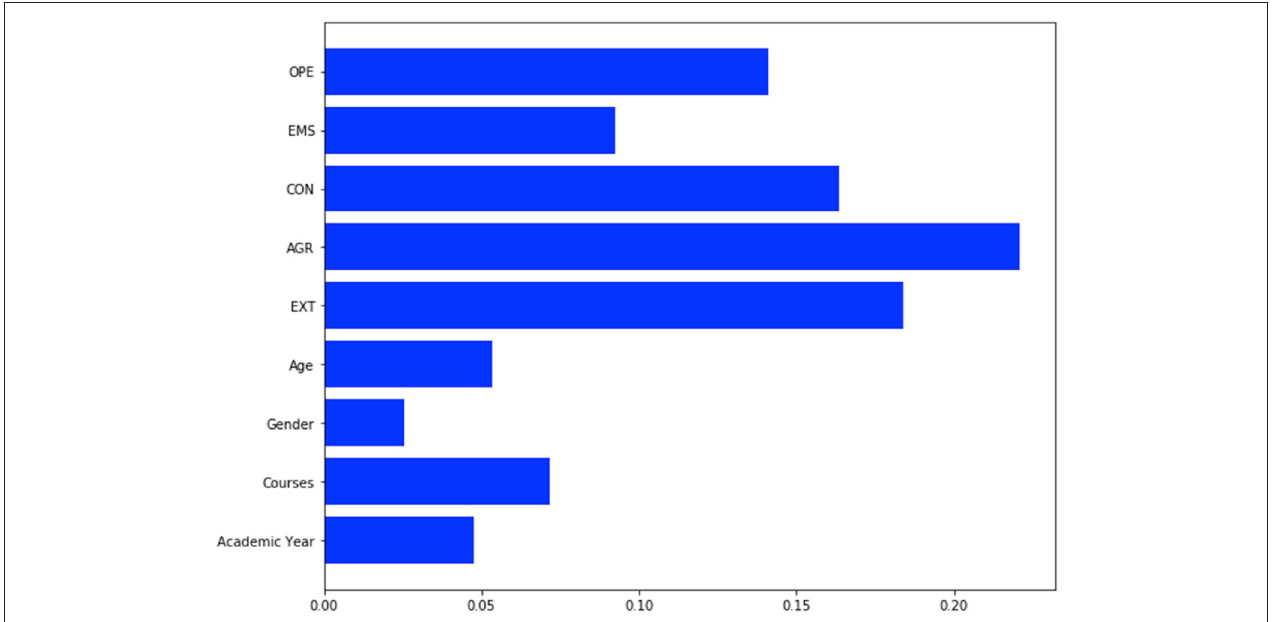
FIGURE 1 | GBR prediction model for Blame item. OPE, Openness; EMS, Emotional Stability; CON, Conscientiousness; AGR, Agreeableness; EXT, Extraversion. Accuracy for Blame is 0.656.